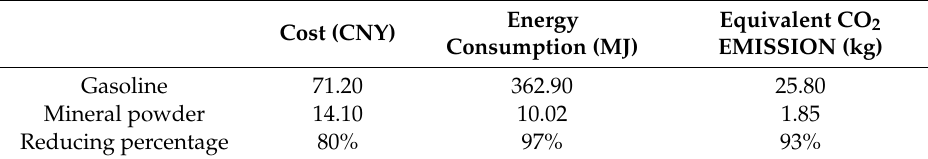
Table 6. Cost and environmental impacts of cleaning 1 kg asphalt with 2 approaches.